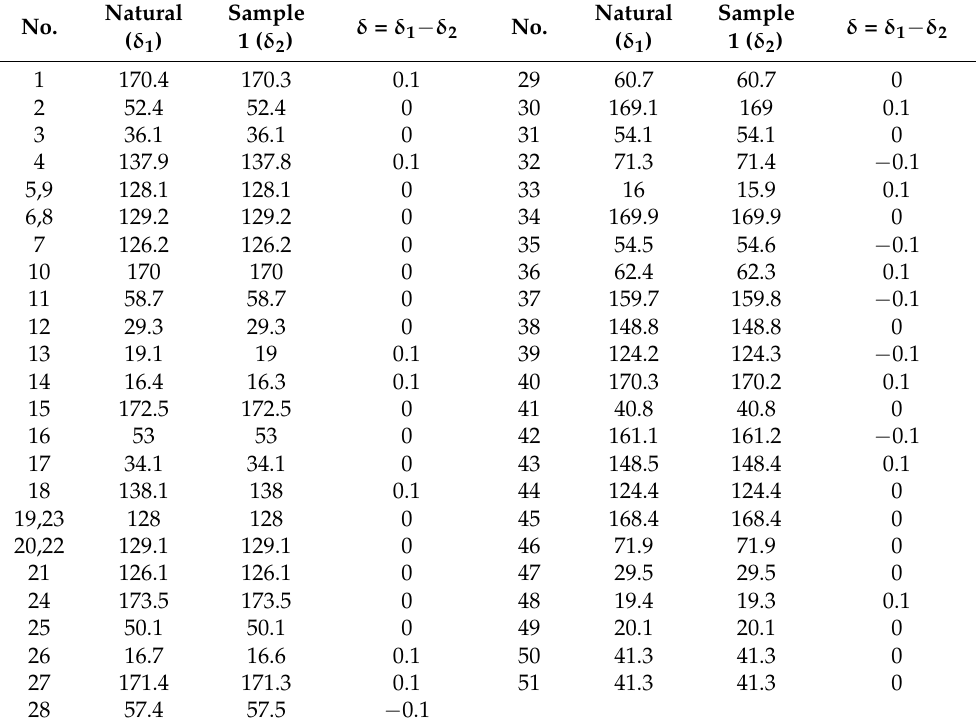
Table 2. Comparison of the 13 C-NMR data of 1 with literature data